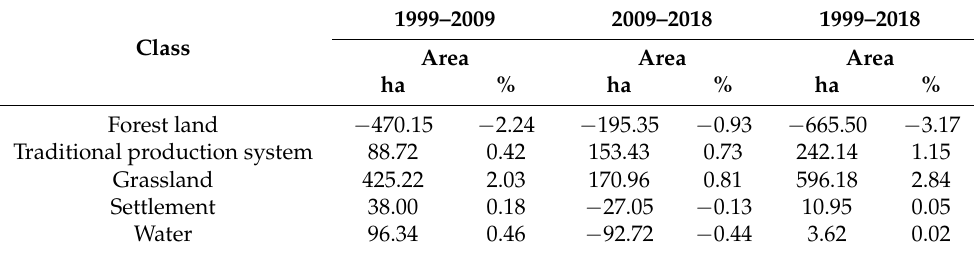
Table 7. Results of the LULC classification for 1999, 2009, and 2018 images, showing the area changed and percentage in the DLZ’s southern zone (In é s Arango Parish) in the Yasun í Biosphere Reserve of the Ecuadorian Amazon